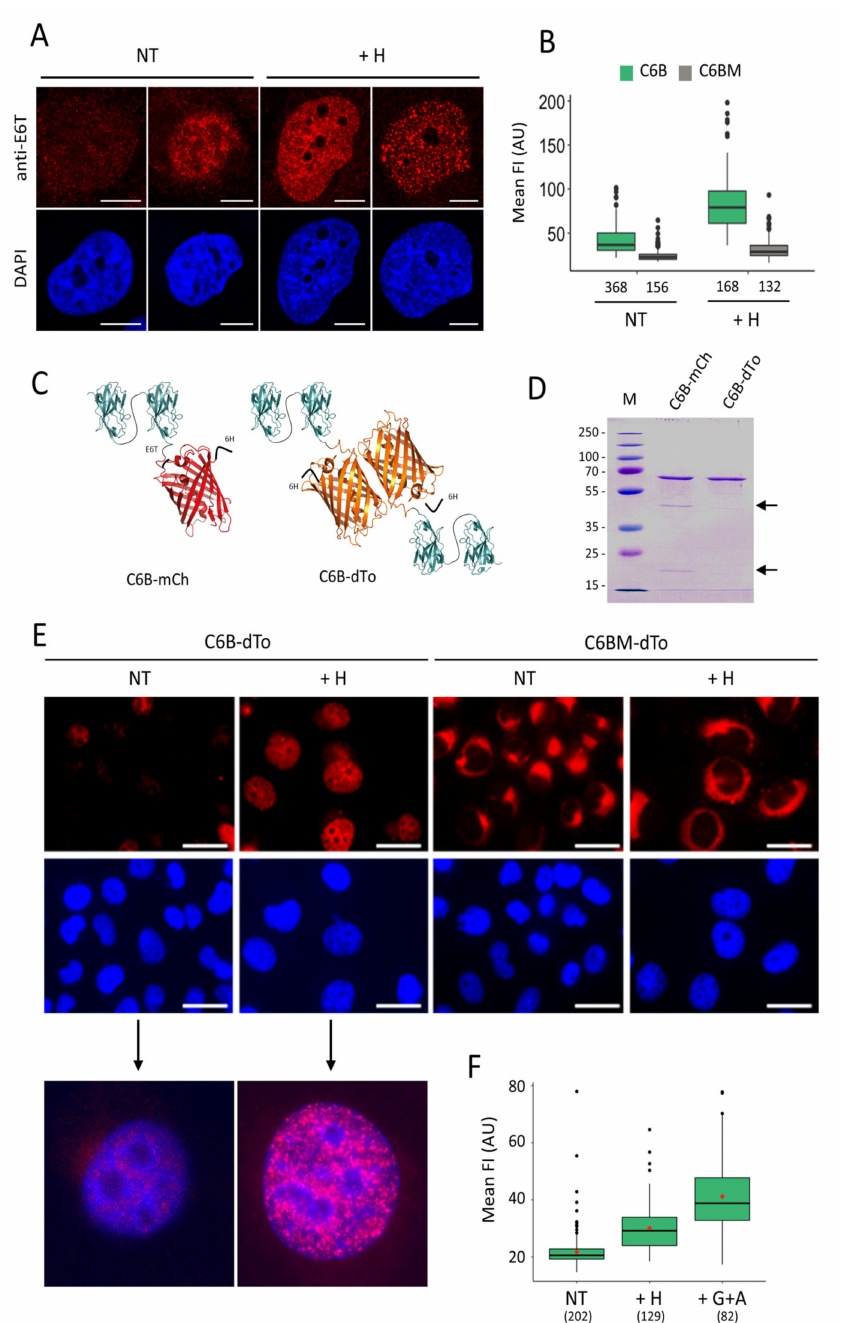
Figure 5. Detection of γ -H2AX with the bivalent nanobody upon delivery by electroporation. ( A ) H1299 cells transduced with either C6B or C6BM nanobodies were treated with hydroxyurea (H) and revealed with anti-tag E6 antibody (anti-E6T) and Alexa 568-labelled anti-mouse globulins 40 h post-treatment. Typical immunofluorescence images of C6B-transduced cells taken with a confocal microscope after DAPI counterstaining (blue) are shown. Scale bar: 10 µ m. ( B ) The quantification of the mean FI of cells transduced as in ( A ) with either C6B (green) or C6BM (grey) are